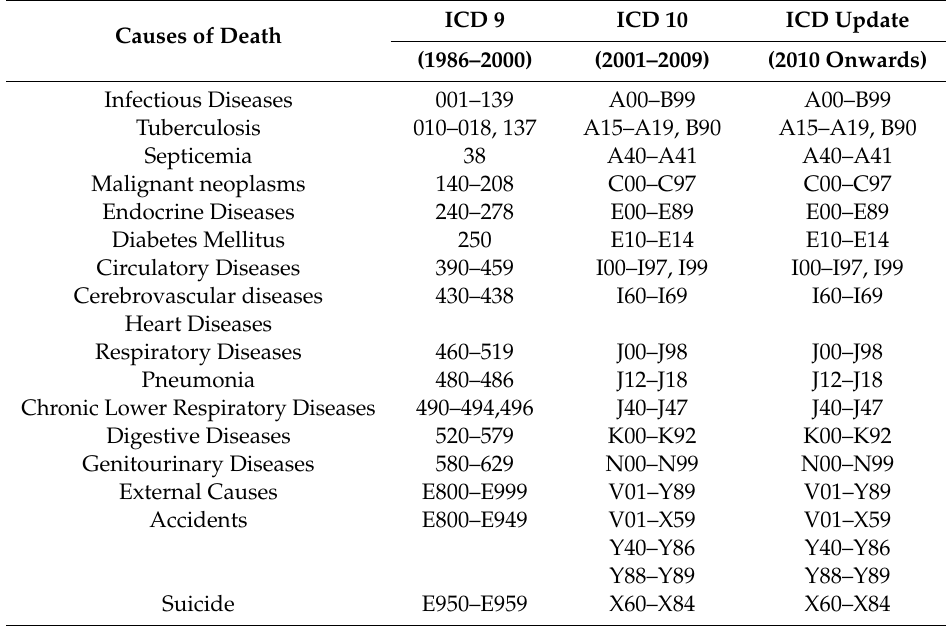
Table A1. Codes for the selected leading causes of death in the di ff erent International Classification of Diseases (ICD)